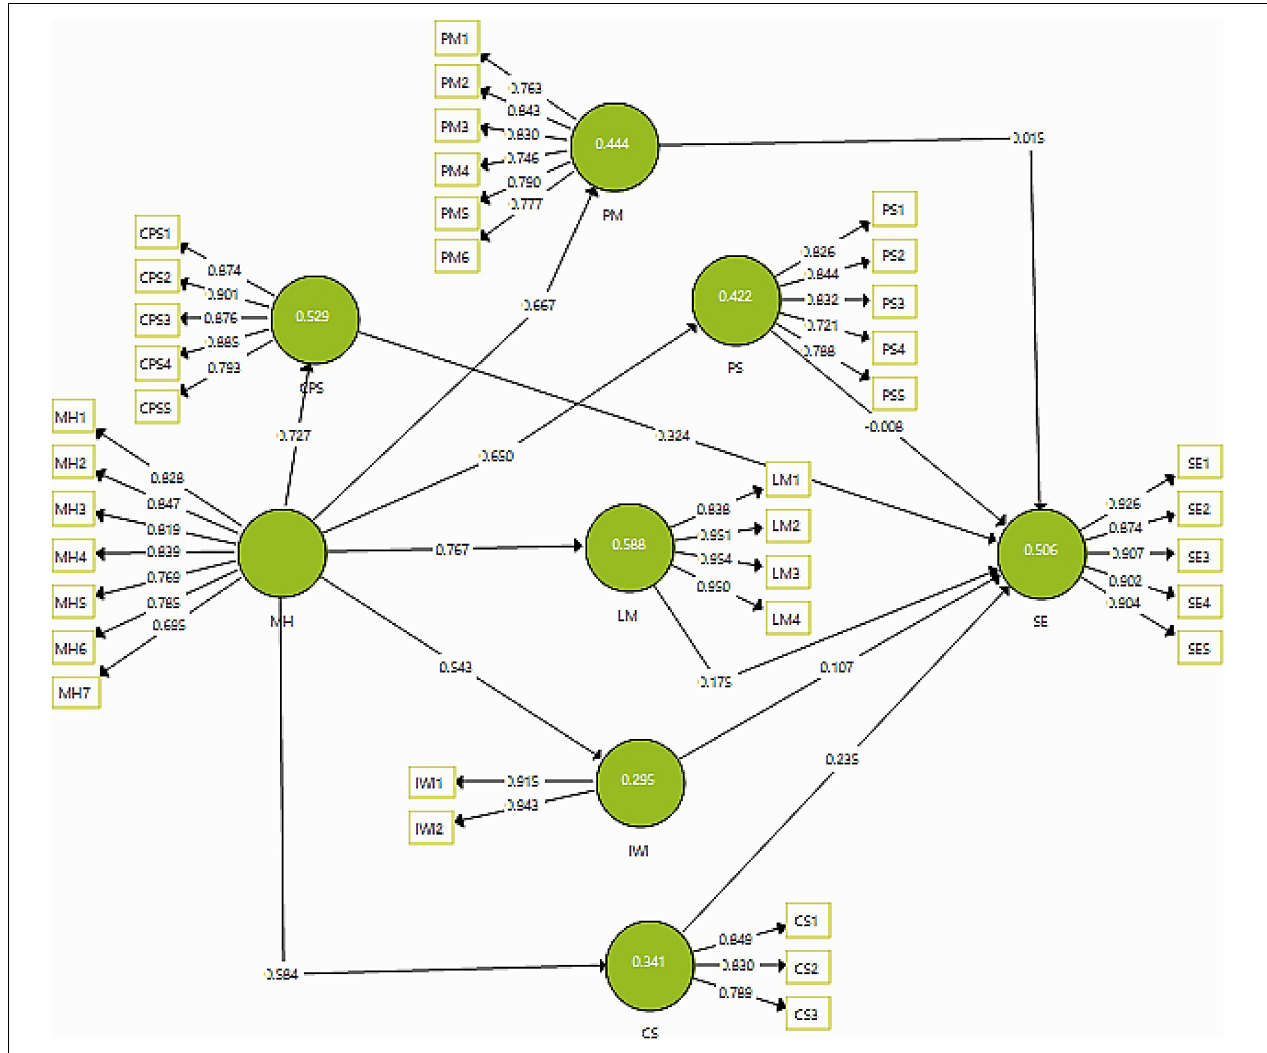
FIGURE 2 | Measurement model analysis. N = 340, CPS, cognitive problem-solving; CS, community support; IWI, interaction with instructor; LM, learning management; MH, mental health; PM, psychological motivation; PS, peer collaboration; SE, sustainable